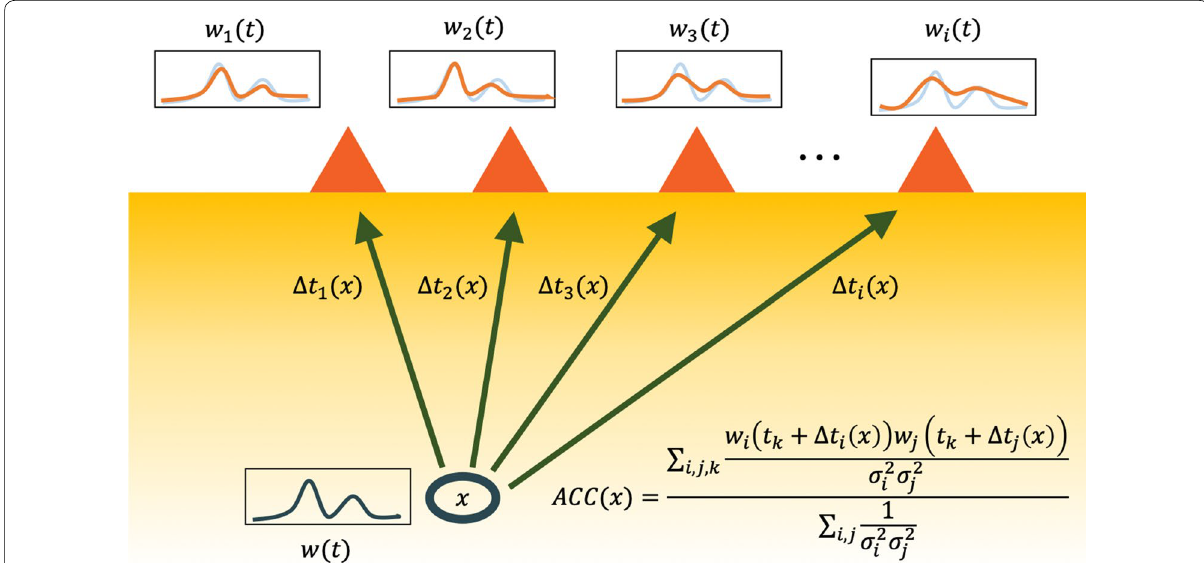
Fig. 1 Schematic diagram of our location method. The observed envelopes at many stations are shown by the red curves in the upper boxes. The light blue curves in the upper boxes are the time-shifted template waveform, which is also shown as the black curve in the lower box. Our method searches for the source location that will maximize ACC, which is the weighted sum of the cross-correlations. The weight is determined based on the similarity between the observed and template waveforms. In this case, the weight of station i is smaller than those at stations 1–3, as the difference between the observed and template waveforms is